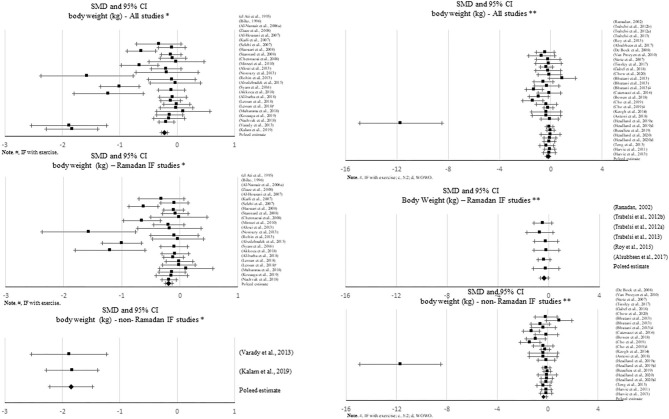
Forest plot of the effects from a fixed-effects meta-analysis shown as standardized mean difference with 95% confidence intervals on fat-free mass (FFM) for only non-Ramadan IF studies. For each study, the square represents the standardized mean difference between pre- and post-intervention time points, with the horizontal line intersecting it as the lower and upper limits of the 95% confidence interval. The rhombi represents the pooled estimated standardized mean difference. *Pre-post tests, IF intervention; **Pre-post tests, IF intervention vs. control.